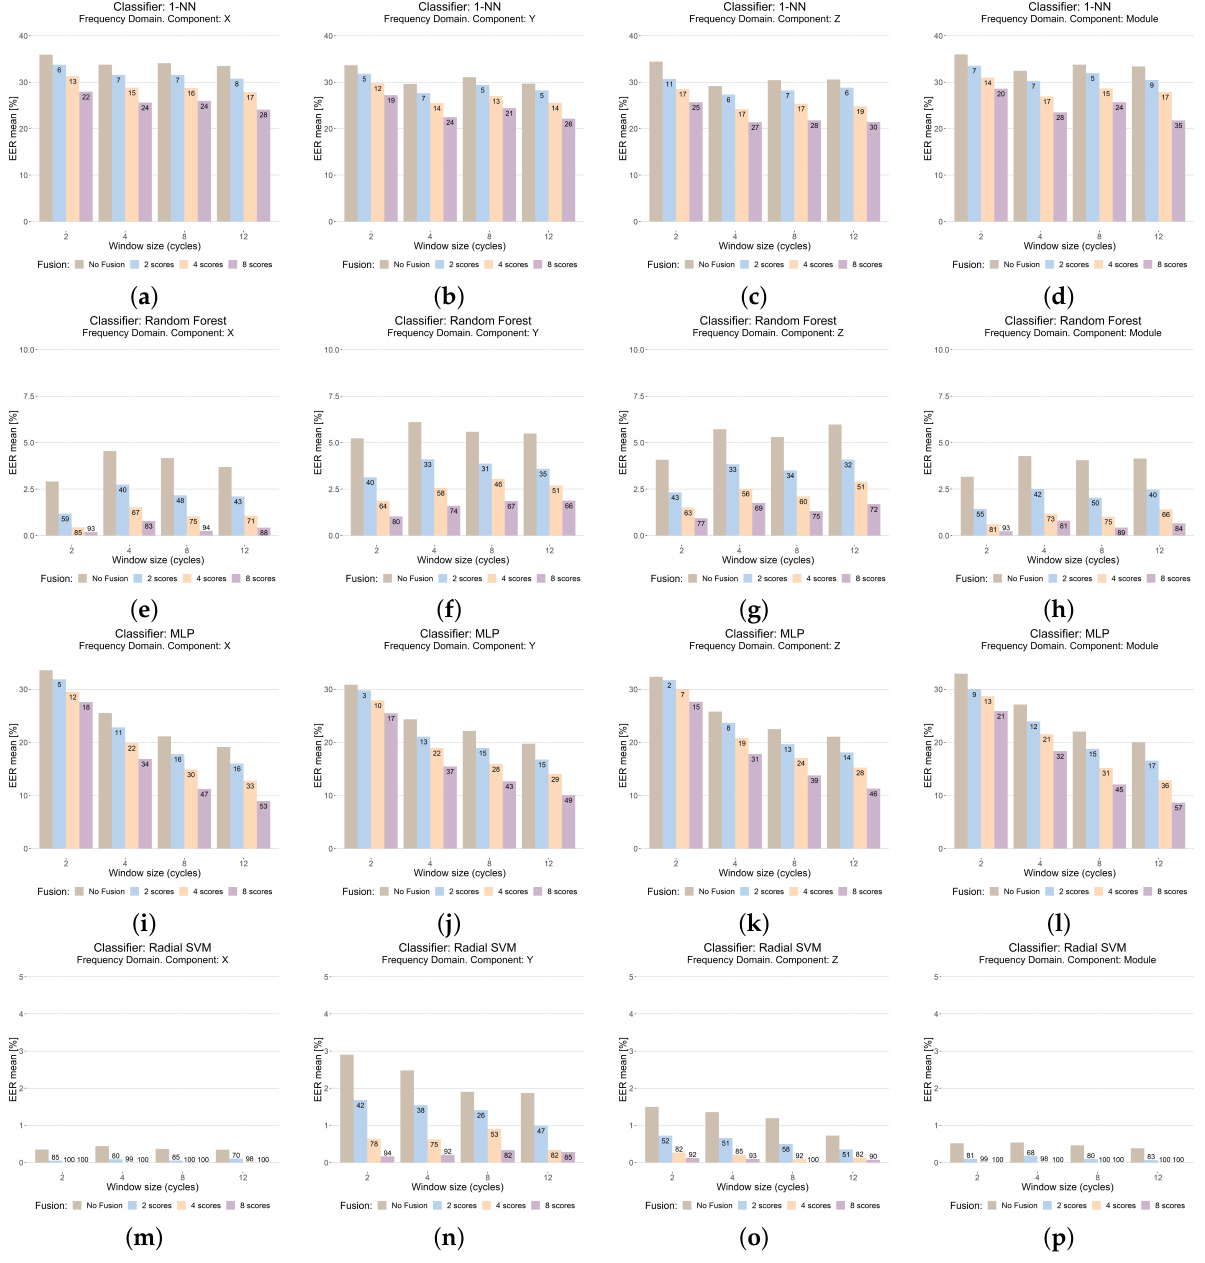
Figure 9. Results in the frequency